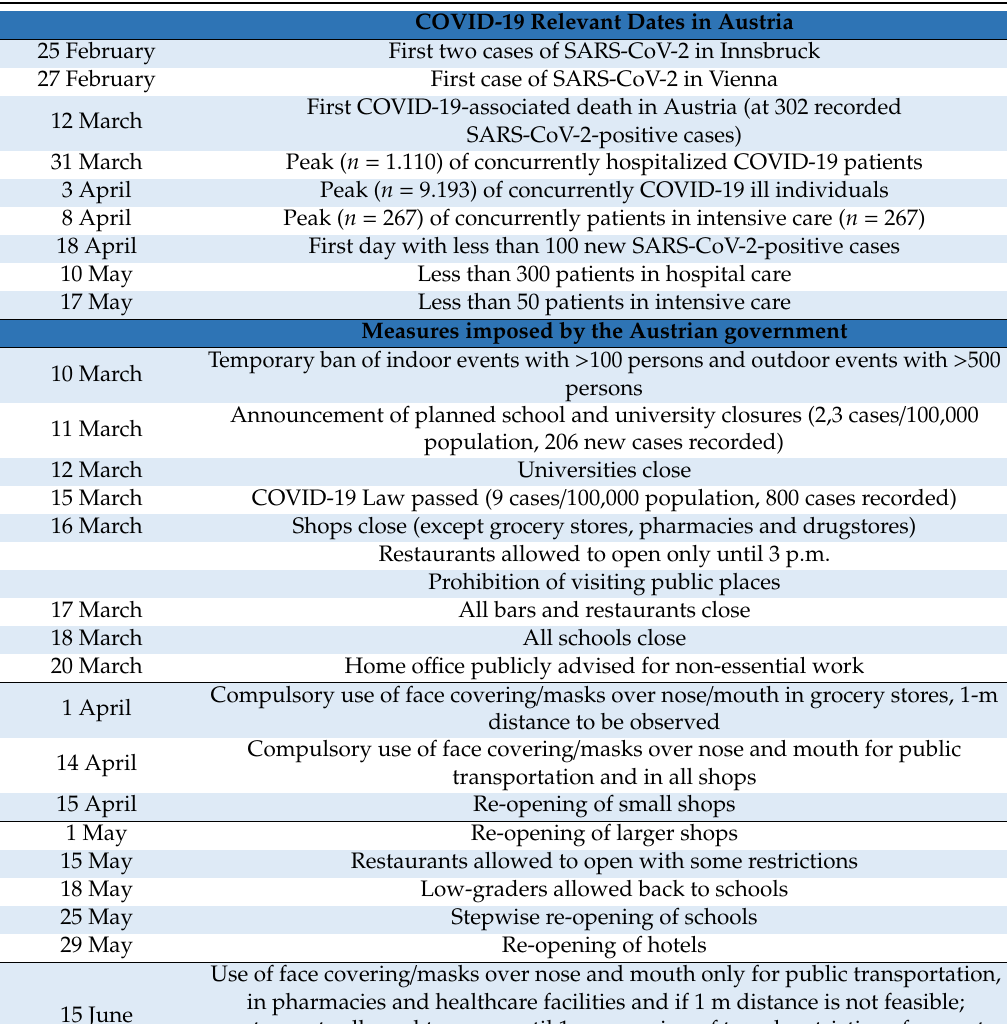
Table 1. Timeline of measures implemented by the Austrian government during the course of concurrent SARS-CoV-2 infections (adapted from https: // www.sozialministerium.at / Informationen- zum-Coronavirus / Coronavirus---Rechtliches.html, accessed on 7 August